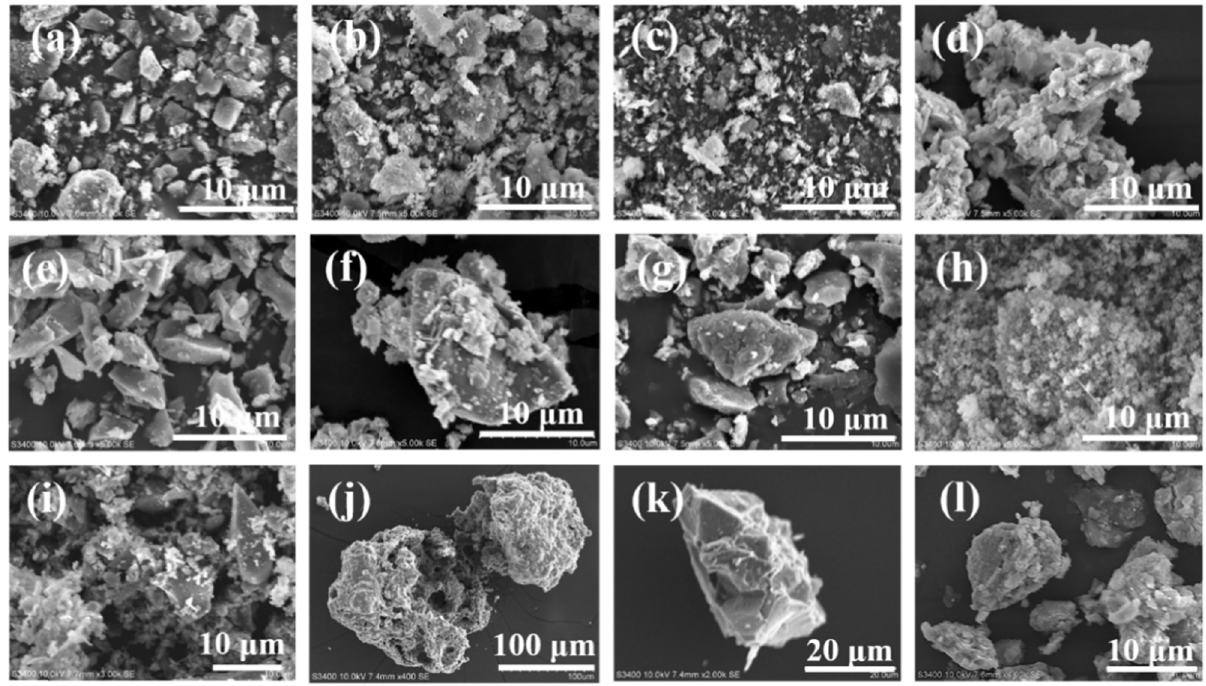
Figure 3: The SEM images of raw materials: ( a ) KL; ( b ) MK - 1; ( c ) MK - 2; ( d ) BFS - 1; ( e ) BFS - 2; ( f ) FA - 1; ( g ) FA - 2; ( h ) SF; ( i ) BEN; ( j ) SB; ( k ) MP; ( l )